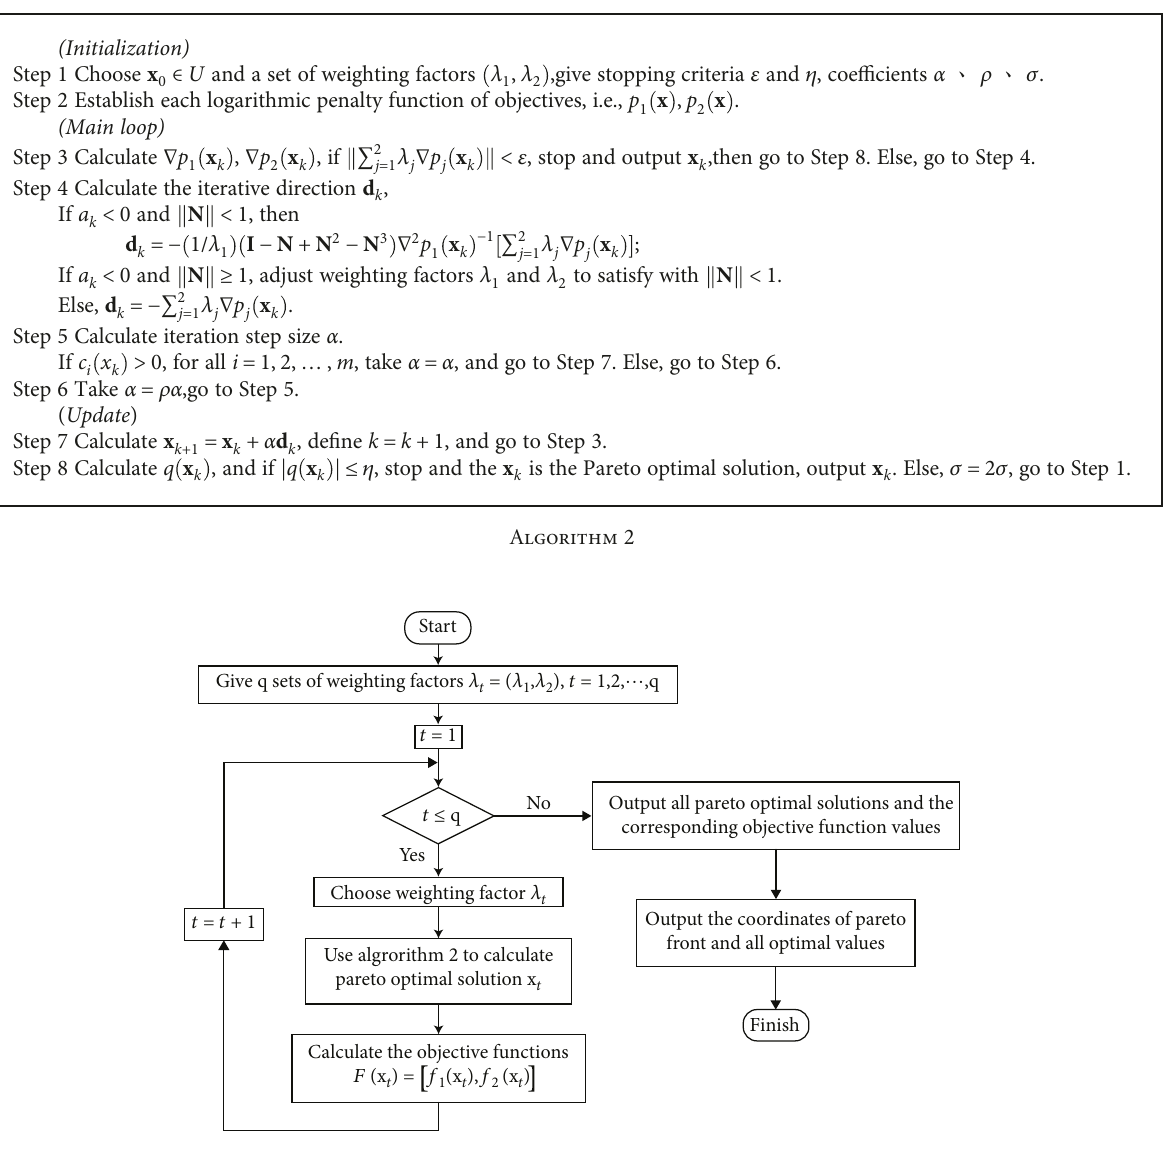
Figure 2: The process of NNSEFA for solving inequality constraints biobjective